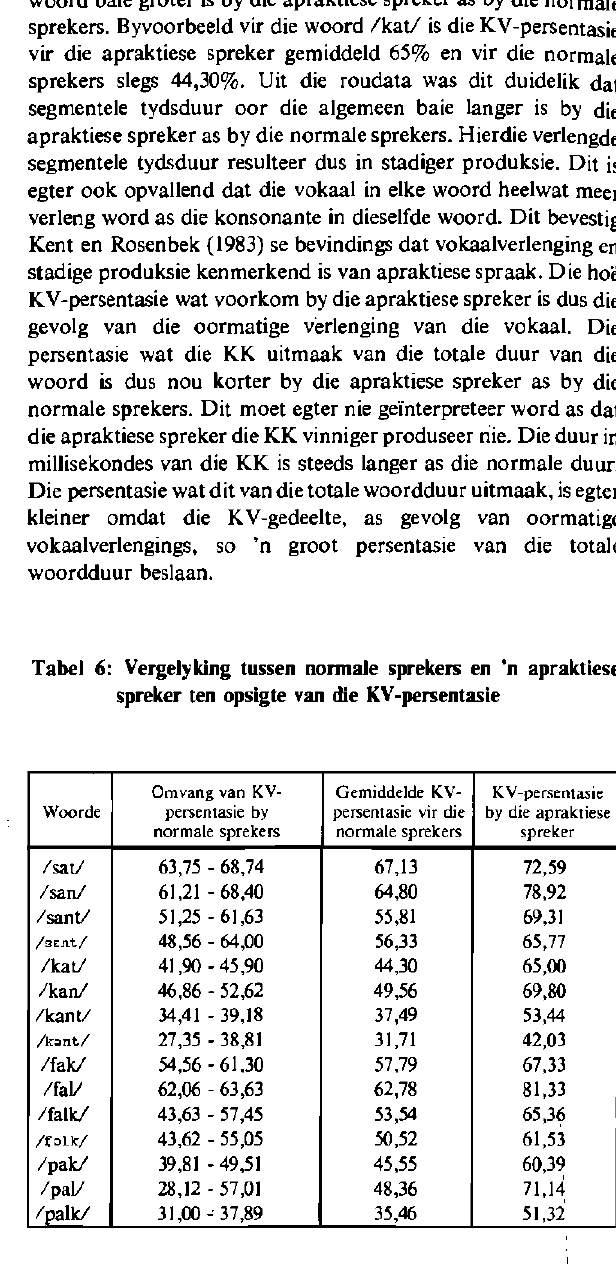
Tabel 6 toon verder aan dat die KV-persentasie van dieselfde